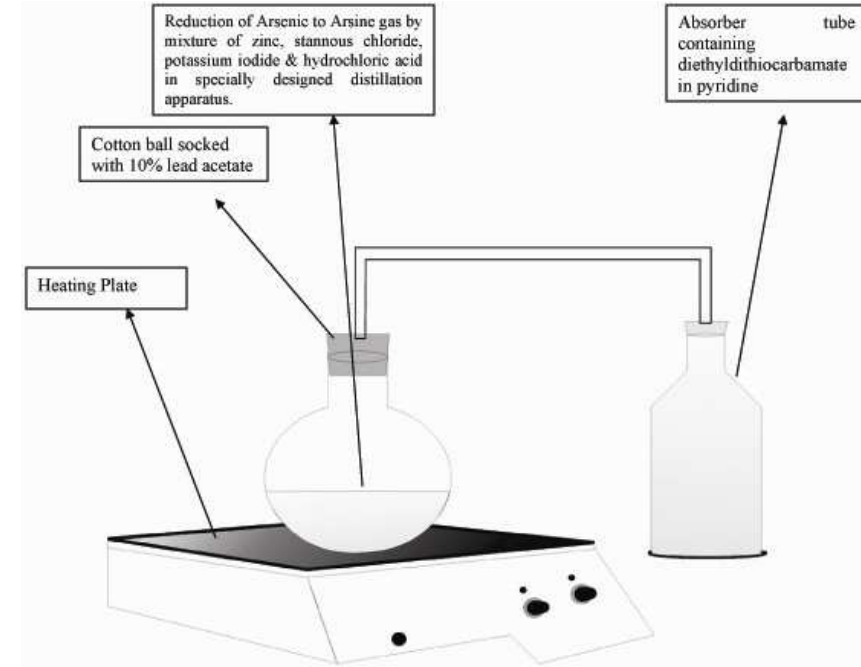
Figure 1: Arsine Generation System Figure 1. Arsine generation